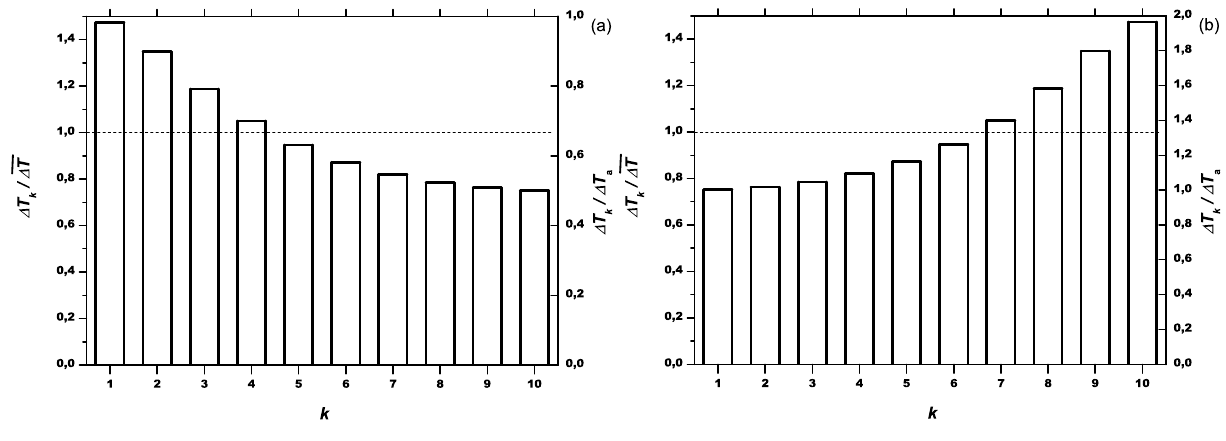
Fig. 5. Histograms showing the recurrence time 1T k /1T (or 1T k /1T a ) as a function of k : (a) V b /V a = 2, (b) V b /V a = 1 / 2 ( β = 1 / 20).